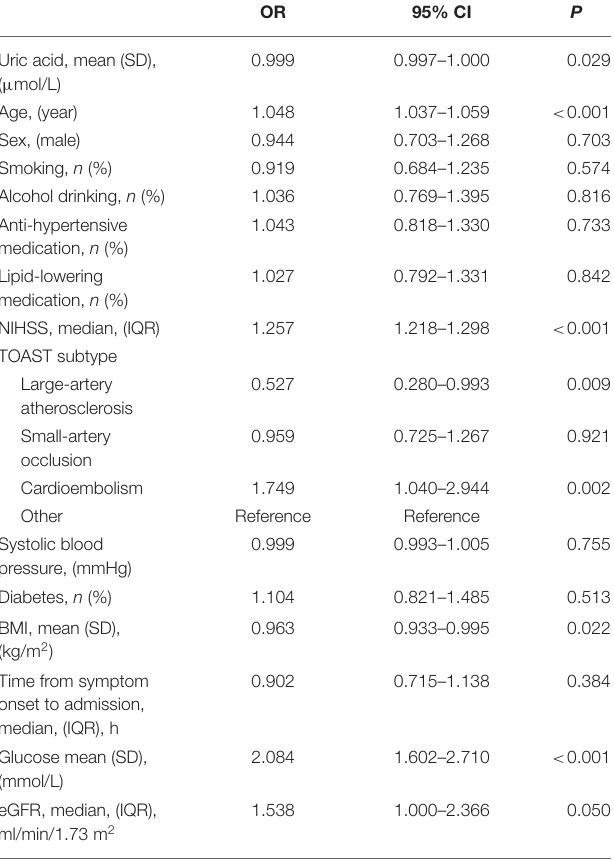
TABLE 3 | Odds ratio (OR) of uric acid for poor outcome (mRS ≥ 3), adjusting for covariates. OR 95% CI